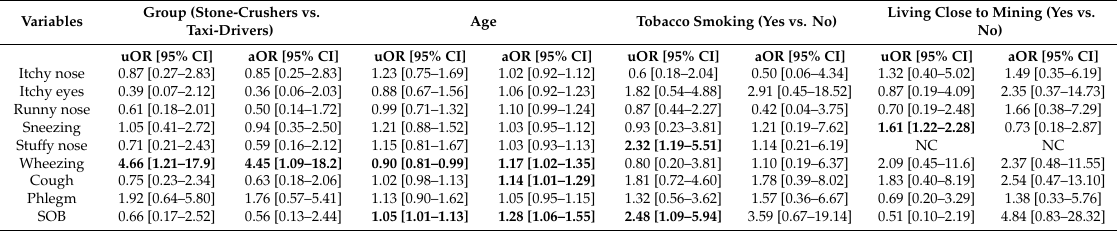
Table 4. Unadjusted and adjusted associations between independent variables and respiratory symptoms in the overall